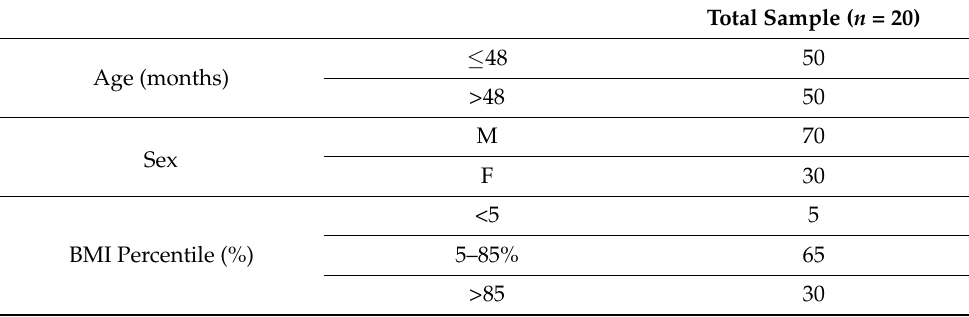
Table 1. Characteristics of preschoolers in the